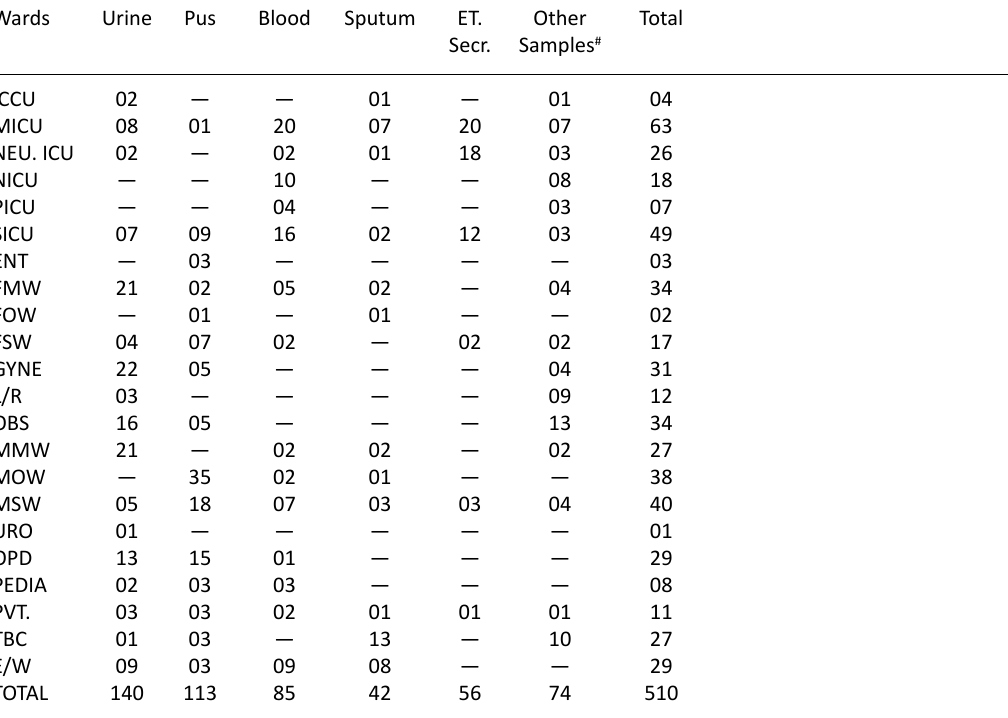
Table 3. Distribution of type of samples obtained from different wards Wards Urine